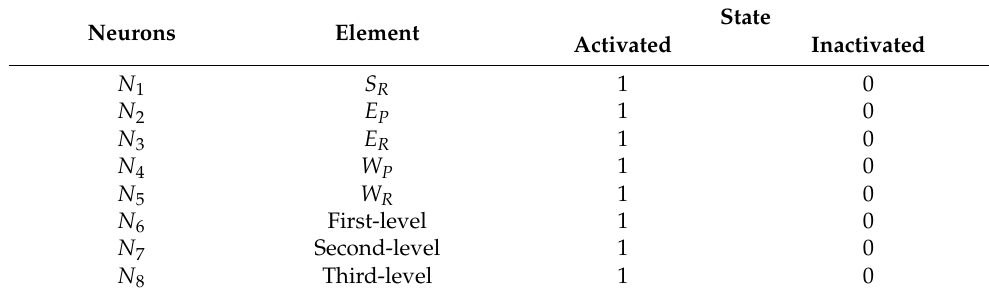
Table 3. The active state of hidden neurons. Neurons Element